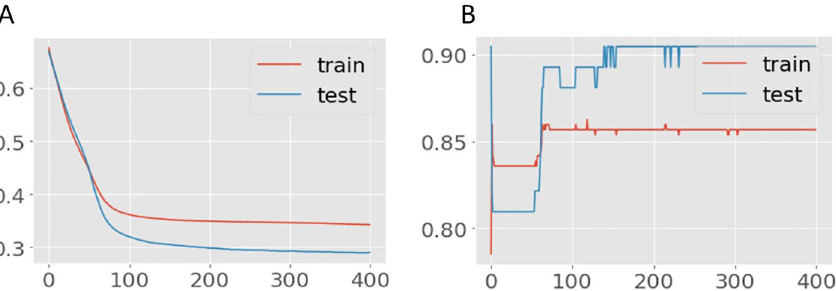
Figure 4. Learning curves of Model 1 (mRSS and WHO-FC ≥ II), ( a ) Training and validation loss, ( b ) the model accuracy in training and validation. Title = ( a ) Model loss ( b ) Model accuracy. X-axis = ( a ) Loss ( b ) Accuracy. Y-axis = ( a ) number of epochs ( b ) number of epochs.